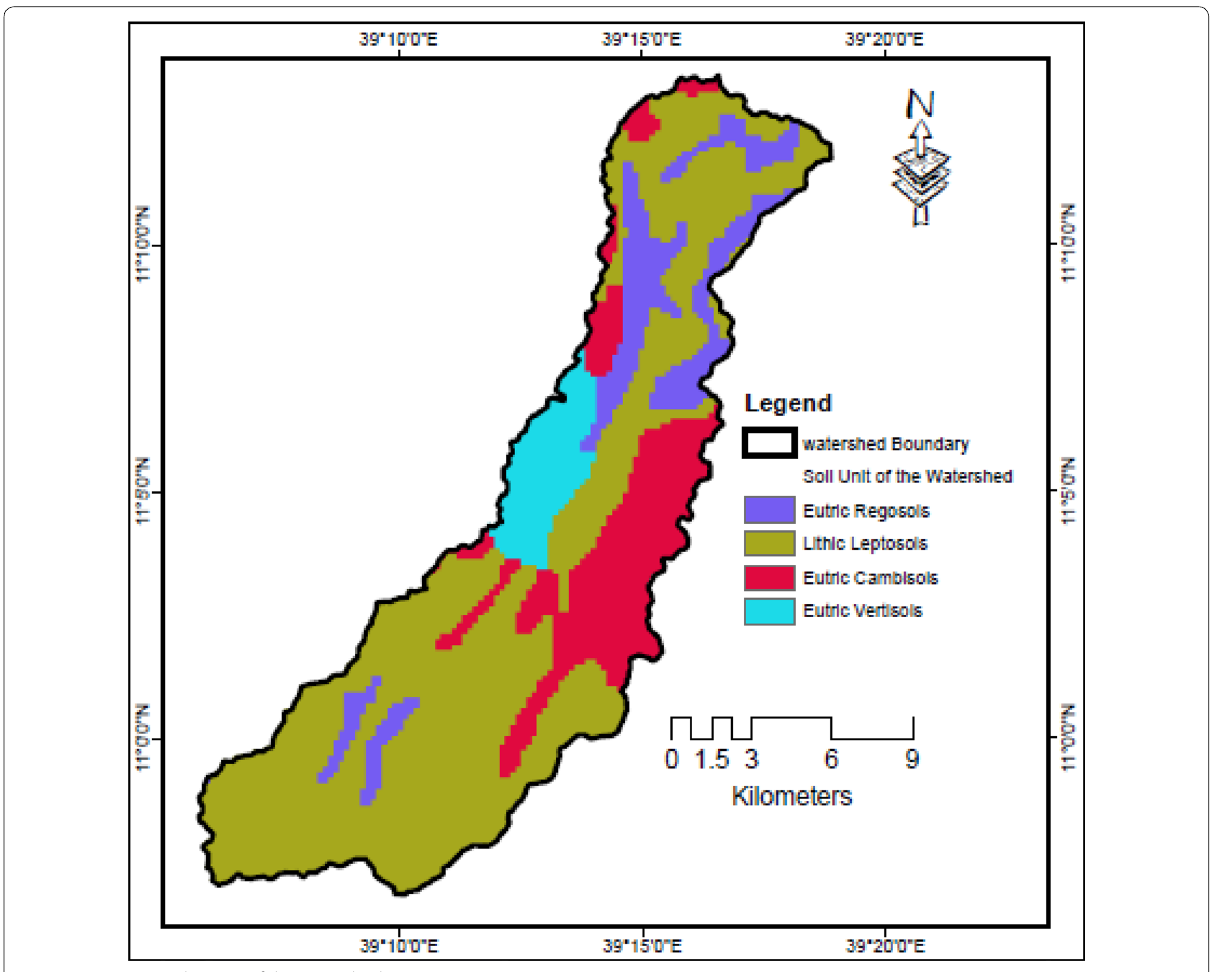
Fig. 4 Dominant soils types of the